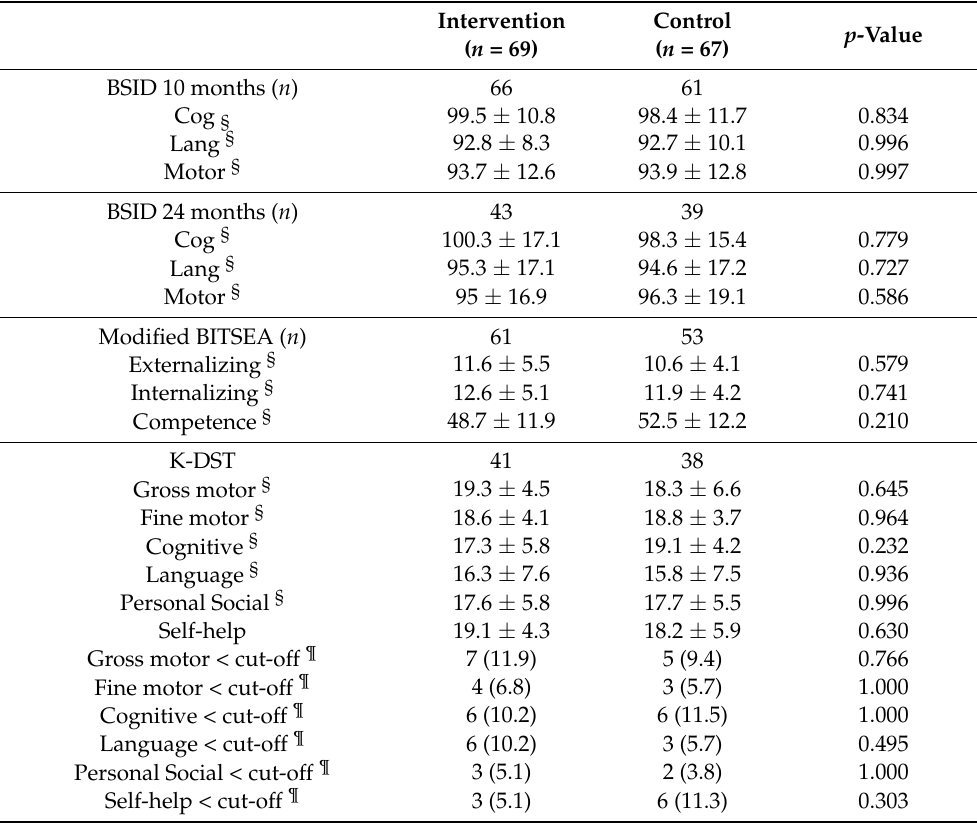
Table 4. Neurodevelopmental outcomes of very preterm babies: intervention vs. control.